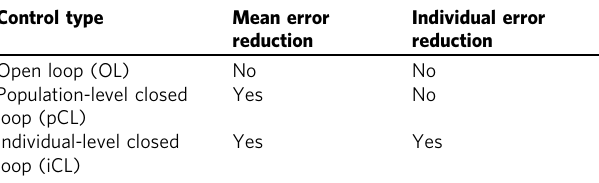
Table 1 Error level reduction by control type Control